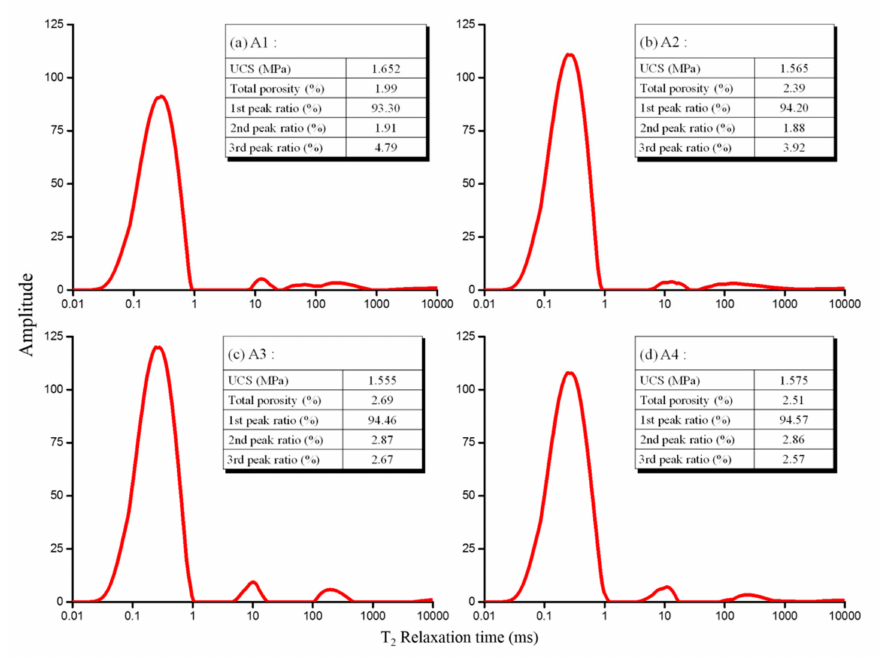
Figure 4. Pore size distribution of group